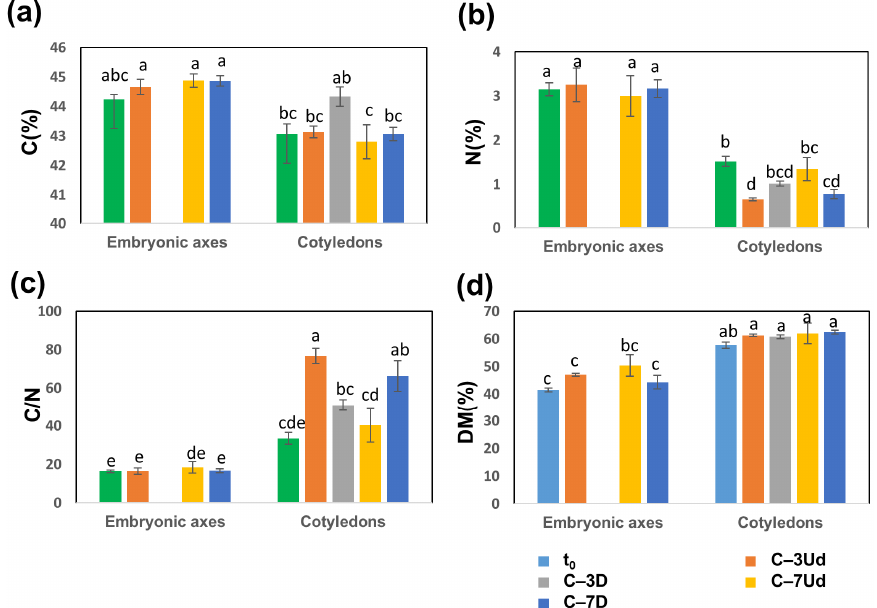
Figure 7. Differences in carbon (C) and nitrogen (N) levels detected in embryonic axes and cotyledons. C ( a ) and N ( b ) were further calculated as the C/N ratio ( c ). Dry matter (DM) percentage calculated for embryonic axes and cotyledons ( d ). Data are the means of three replicates ± SE. Different letters indicate significant differences according to the HSD post hoc test ( α = 0.05). The highest C (%) was detected in the damaged cotyledons of acorns stored at − 3 °C, and the lowest was reported in acorns stored at − 7 °C, particularly in undamaged cotyle- dons. The lowest average level of C (%) in undamaged cotyledons stored at − 7 °C was accompanied by a decreased level of starch (Figure 8a) and an increased level of soluble carbohydrates (Figure 8b), two symptoms of the activation of the utilization of stored car- bohydrate reserves. In contrast, in the damaged cotyledons of seeds stored at − 7 °C, such changes in carbohydrates were not observed, despite relatively low C (%) levels (Figure 7a, Figure 8). The level of N in cotyledons varied among the analyzed treatments, being highest in the control (t 0 ) and in undamaged seeds stored at − 7 °C and lowest in undam- aged seeds stored at − 3 °C (Figure 7b), which was reflected in the highest C/N ratio (Figure 7c). DAMs were subjected to metabolic pathway enrichment analysis (Figure 9). Interest- ingly, starch and glucose metabolism, as well as pentose and glucoronate interconver-